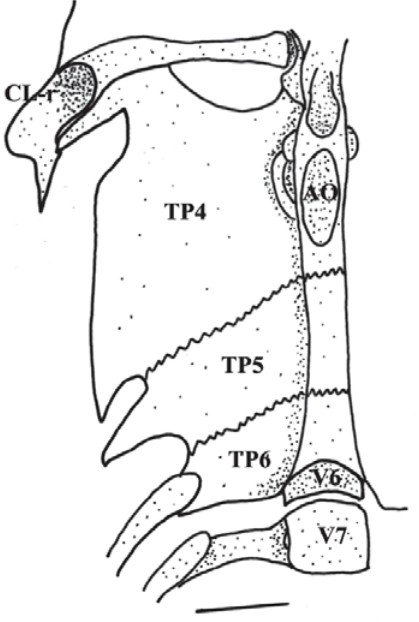
Fig. 6. Pimelodus joannis , UNT 5641, 54.0 mm SL. Ventral view of right side of Weberian complex, basioccipital region and upper shoulder girdle. AO = aortic groove; CL-r = “cleithral ring”; TP4-6 = transverse processes of vertebra 4 to 6; V6-7 = vertebrae 6 and 7. Scale bar = 1